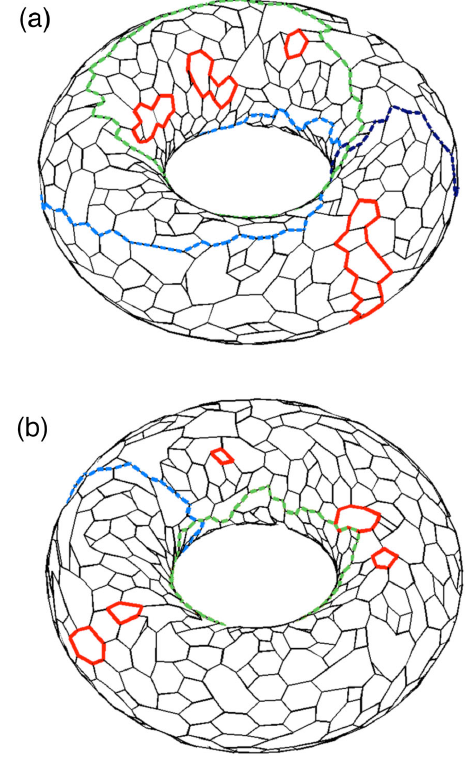
FIG. 3. A graph embedded on a toroidal surface. Highlighted are example basis vectors from (a) a fundamental cycle basis and (b) a minimum weight basis. Red: Some representative tiling basis vectors. Blue and green: Basis vectors that correspond to the 2 g ¼ 2 generators of the fundamental group of the torus.